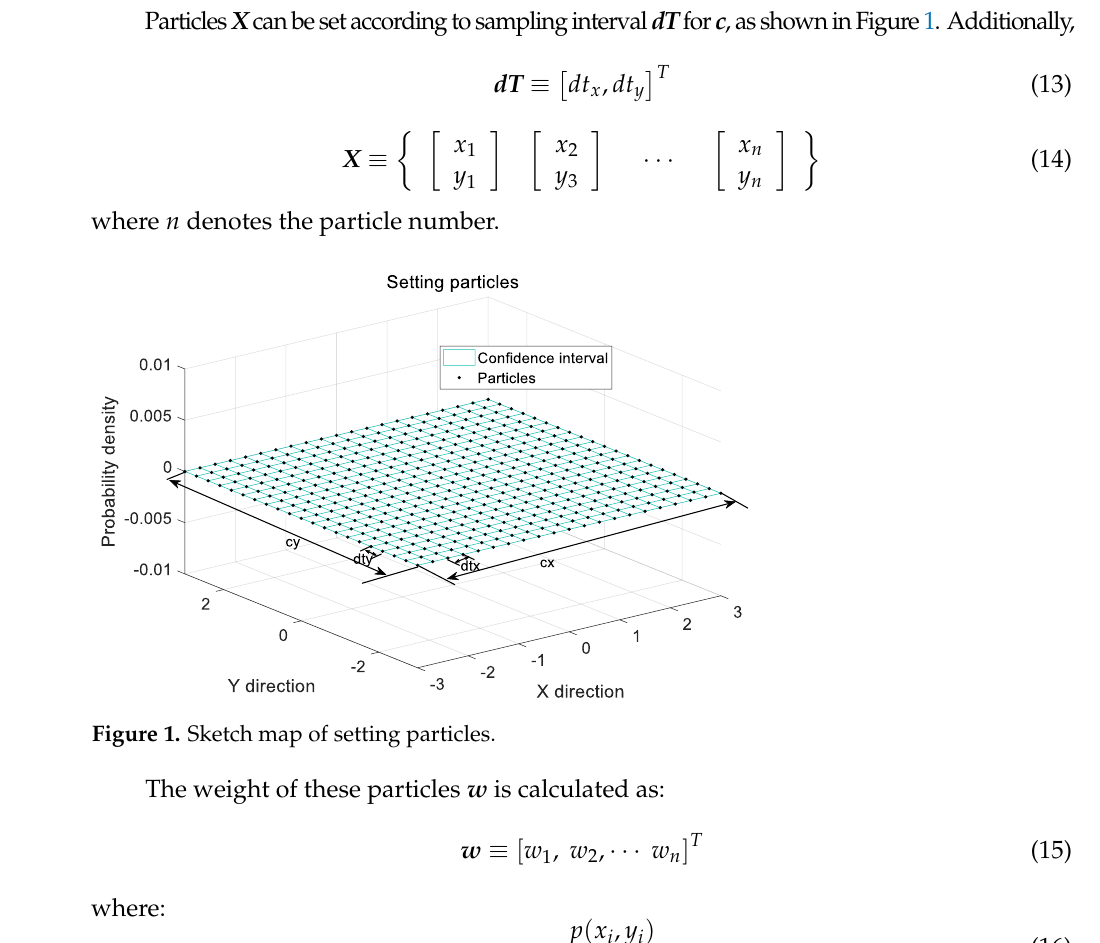
with the accuracy of 1   discretely. The sketch map of the particles and